Question: Describe this figure in one sentence.
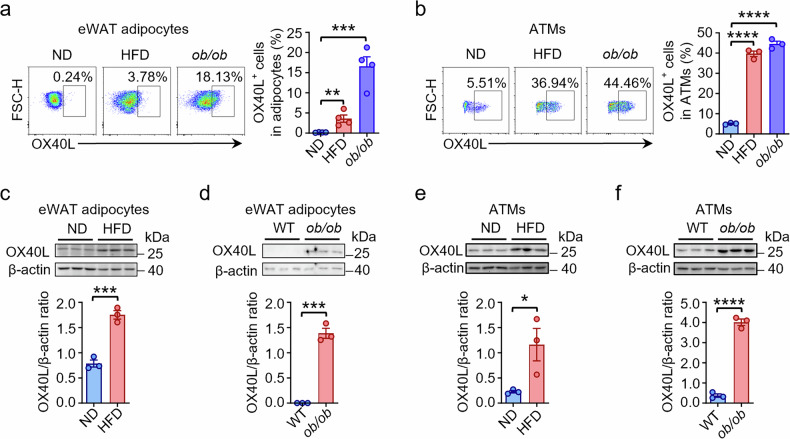
Answer: Obesity induces OX40L expression in adipocytes and adipose tissue macrophages. a Flow cytometry analysis of OX40L + cell proportions in epididymal white adipose tissue (eWAT) adipocytes from mice on a normal diet (ND), mice on a high-fat diet (HFD) (12 weeks) and ob/ob mice ( n = 4 per group). b Flow cytometry analysis of OX40L + cell proportions in eWAT macrophages from mice on a ND, mice on a HFD (12 weeks) and ob/ob mice ( n = 3 per group). c Western blot analysis of OX40L protein expression in eWAT adipocytes from mice on a ND and those on a HFD for 12 weeks ( n = 3 per group). d Western blot analysis of OX40L protein expression in eWAT adipocytes from wild type (WT) and ob/ob mice ( n = 3 per group). e Western blot analysis of OX40L protein expression in eWAT macrophages from mice on a ND and those on a HFD for 12 weeks ( n = 3 per group). f Western blot analysis of OX40L protein expression in eWAT macrophages from wild type and ob/ob mice ( n = 3 per group). Data represent mean ± SEM. * P < 0.05, ** P < 0.01, *** P < 0.001 and **** P < 0.0001. ATMs, adipose tissue macrophages; FSC, forward scatter.